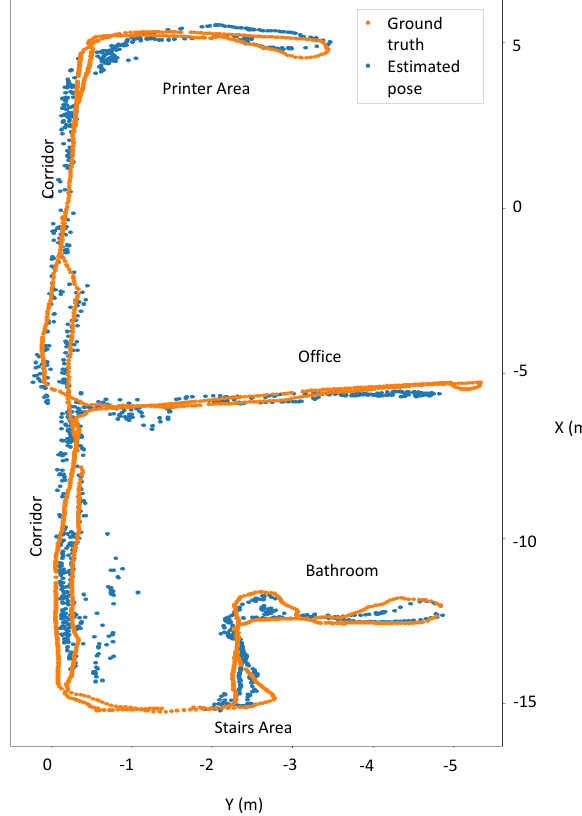
Figure 5. Global representation of the coordinates. The orange points represent the ground truth and the blue points are the estimations made by the regression CNNs from each test image.